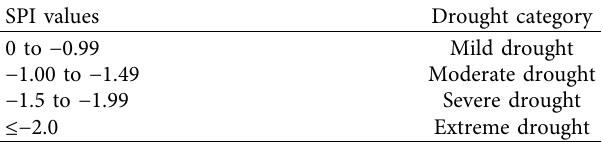
Table 1: Drought intensities according to SPI values [63]. SPI values Drought